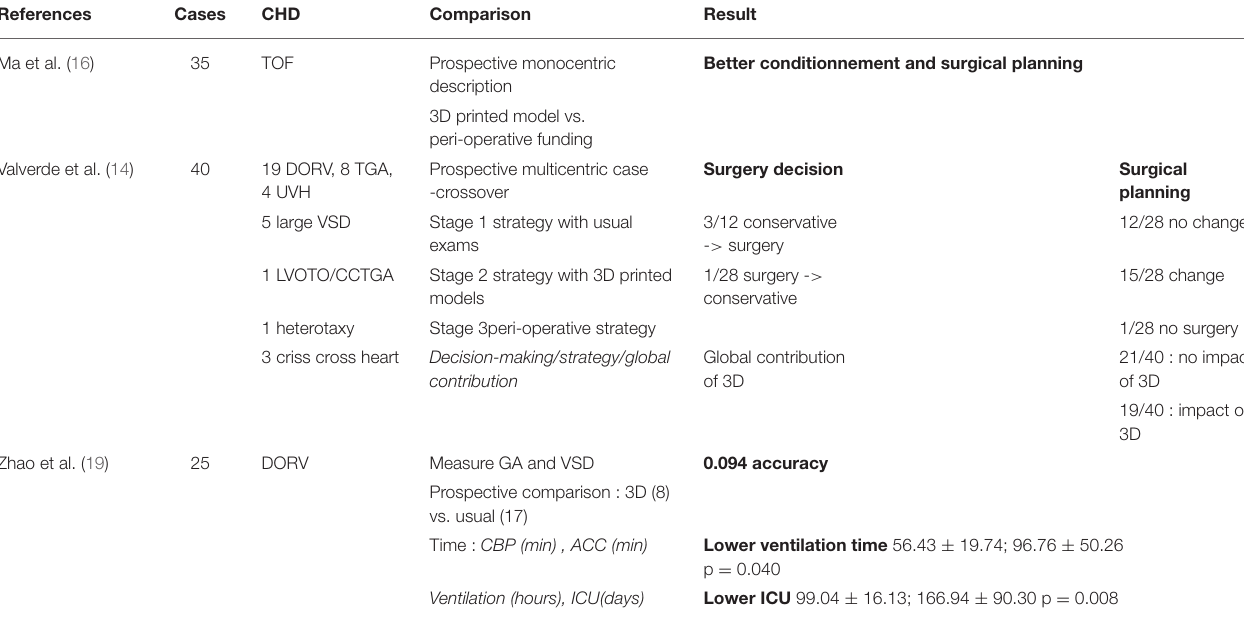
TABLE 3 | Studies about benetif of 3D printing technology in complex CHD’s surgical